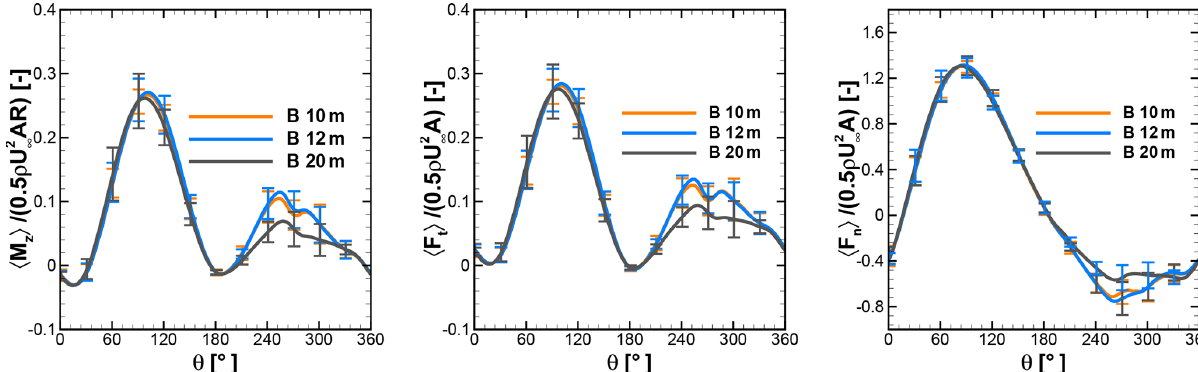
Figure 16. Normalized moment and tangential and normal forces of a single blade at λ = 2 . 75 under turbulent inflow at rooftop of B.